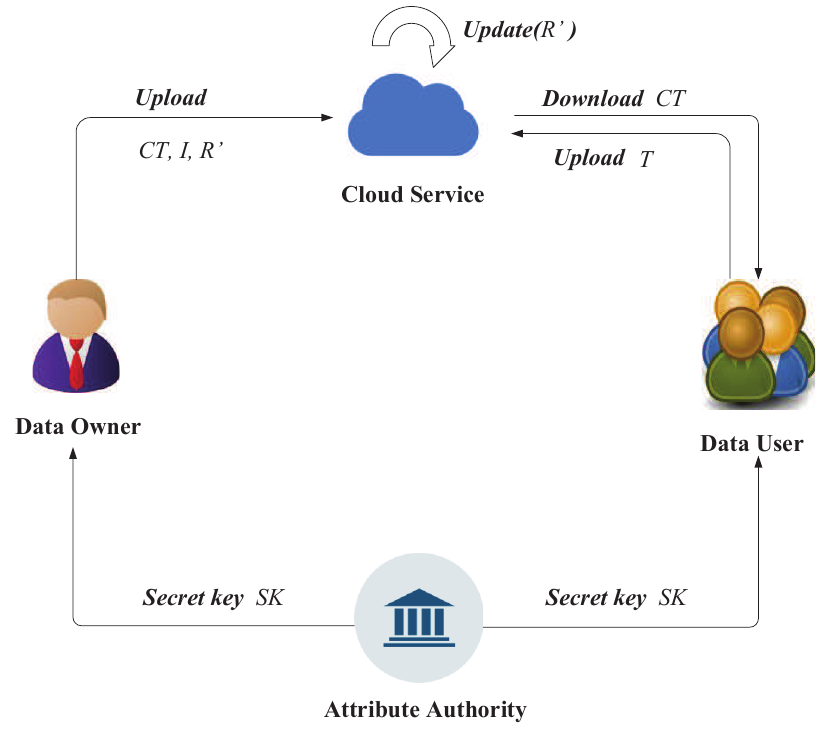
Figure 2. The data sharing system. CT is the ciphertext, I is the keyword index, R’ is the revocation list, T is the keyword trapdoor and SK is the secret